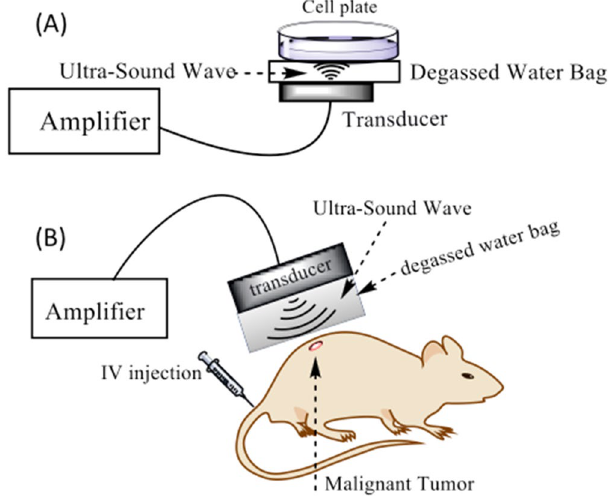
Figure 2. In-vitro and in-vivo experimental designs for sonodynamic therapy.